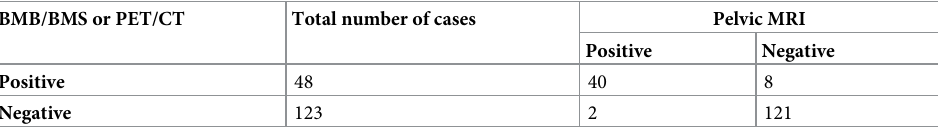
Table 4. Pelvic MRI for the diagnosis of BMinv in DLBCL